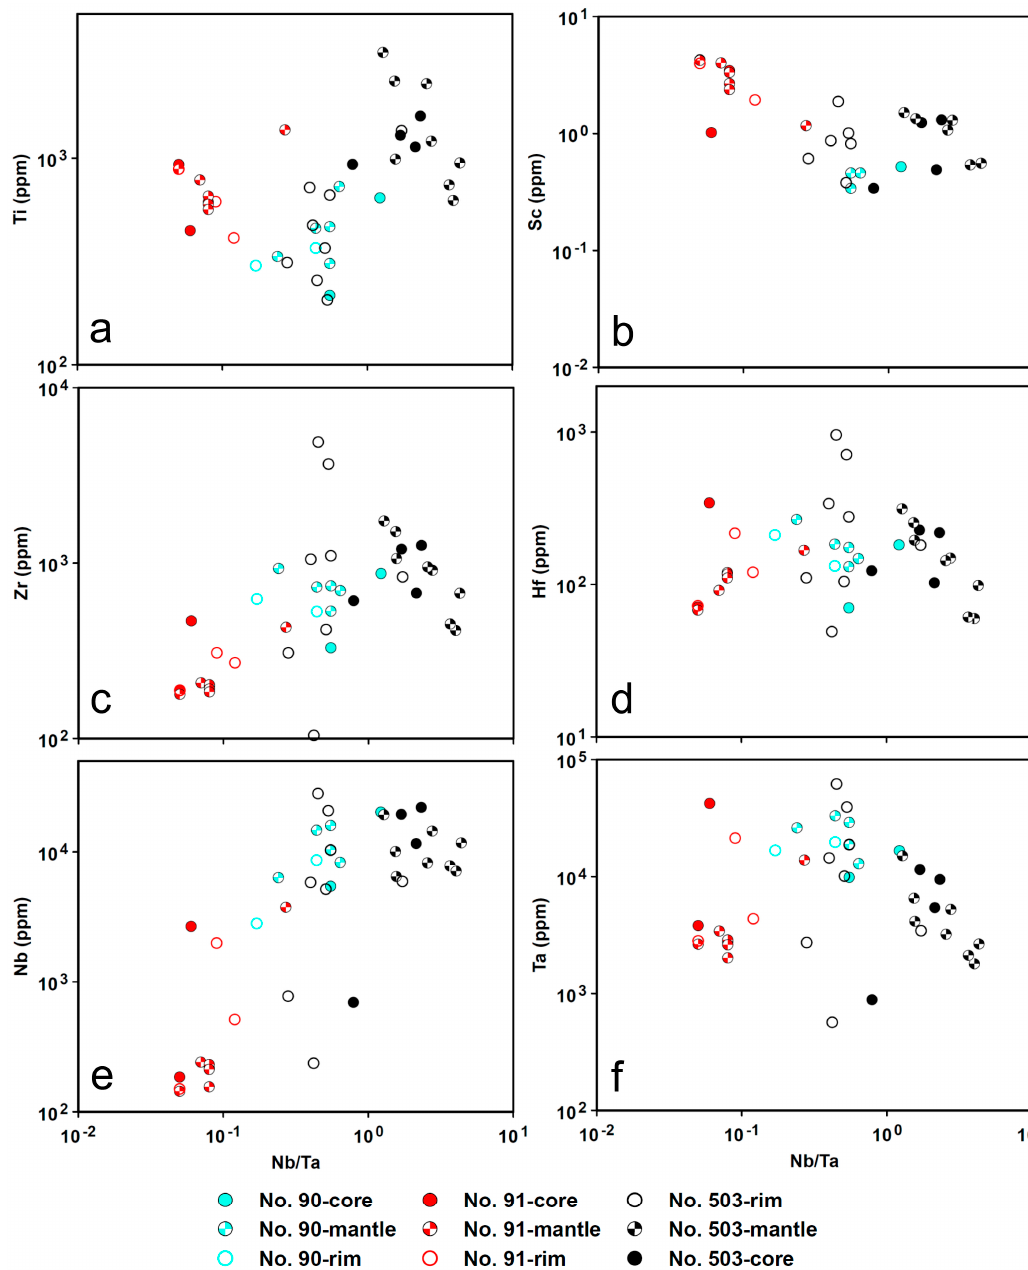
Figure 11. Binary plots of important elements versus Nb/Ta ratio for cassiterite from No. 90 and 503 pegmatites based on the results of LA-ICP-MS analysis. ( a ) Ti vs. Nb/Ta; ( b ) Sc vs. Nb/Ta; ( c ) Zr vs.